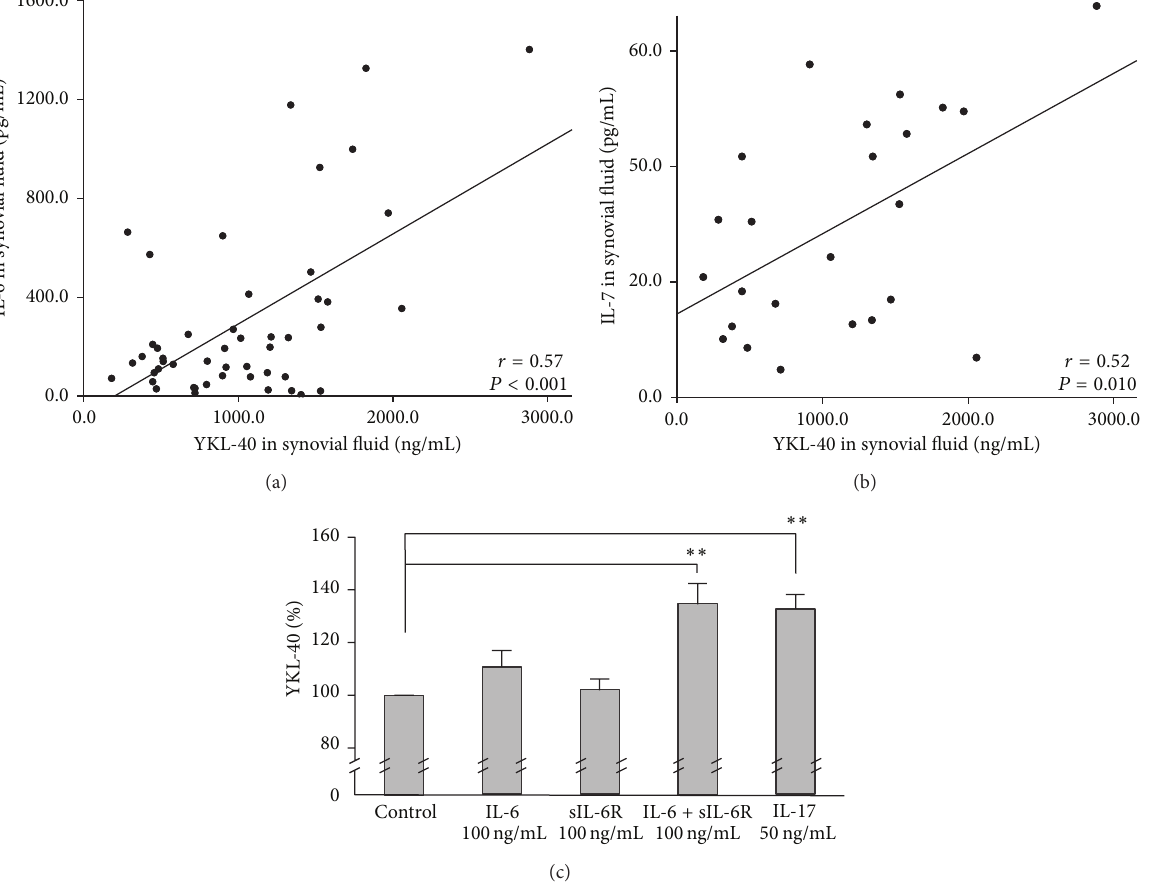
Figure 4: Relation of YKL-40 to proinflammatory cytokines IL-6 and IL-7. In synovial fluid, YKL-40 correlated positively with (a) IL-6 and (b) IL-17 ( 𝑟 = 0.57 , 𝑃 < 0.001 and 𝑟 = 0.52 , 𝑃 = 0.010 , resp.). In the case of IL-17, the levels were measured from SF samples from 47 patients but the levels remained below the detection limit in about half of the patients ( 𝑛 = 23 ) and they were excluded from the correlation analysis. (c) In a 24h incubation IL-6 together with its soluble receptor (sIL-6R) and IL-17 stimulated YKL-40 production by over 30% in primary chondrocytes from OA cartilage. Results are presented as mean ± SEM. ∗∗ 𝑃 < 0.01 compared to the control sample.